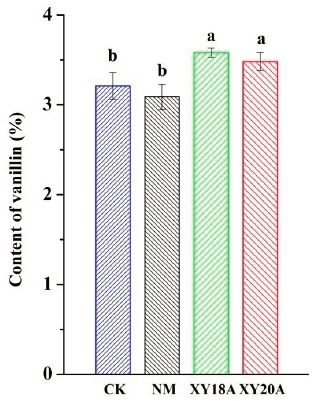
Figure 1. Vanillin content of vanilla beans under different curing processes. Data were subjected to Duncan’s test ( p < 0.05). “a” and “b” mean that the significant differences of data subjected to Duncan’s test.